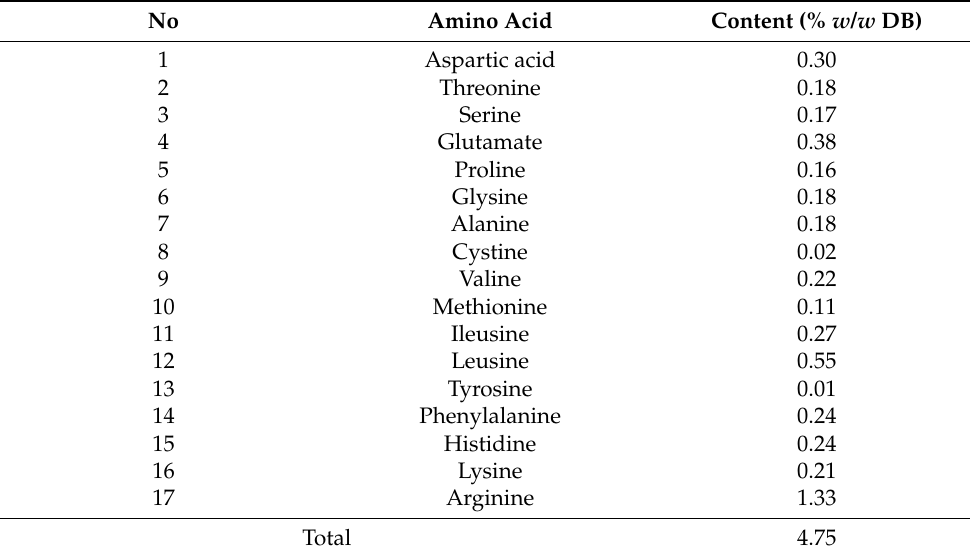
Table 2. Amino-acid content of the fungus combs from the M. gilvus